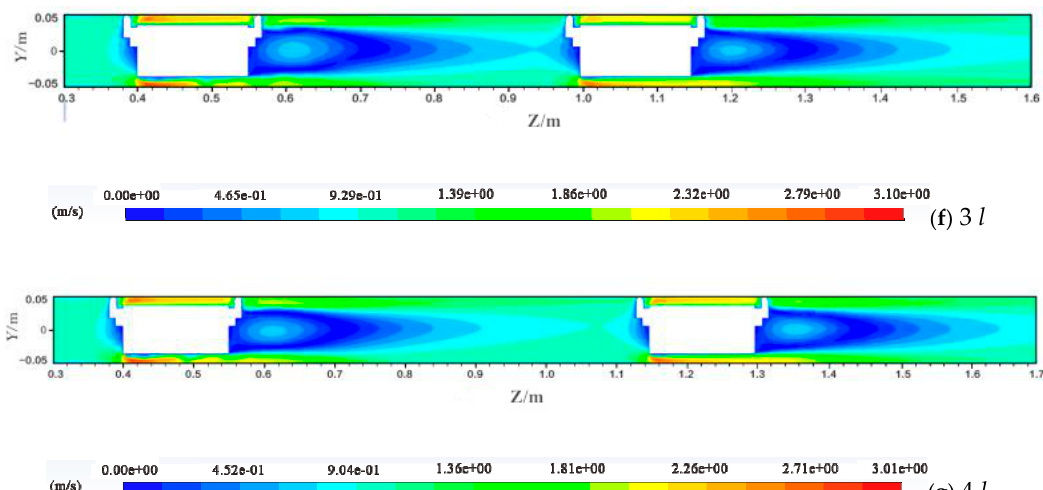
Figure 9. Velocity magnitude distribution cloud map of the YZ plane under di ff erent vehicle spacings.